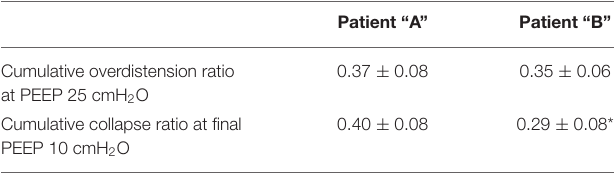
TABLE 3 | Overdistension ratio at top and collapse ratio at final PEEP levels.